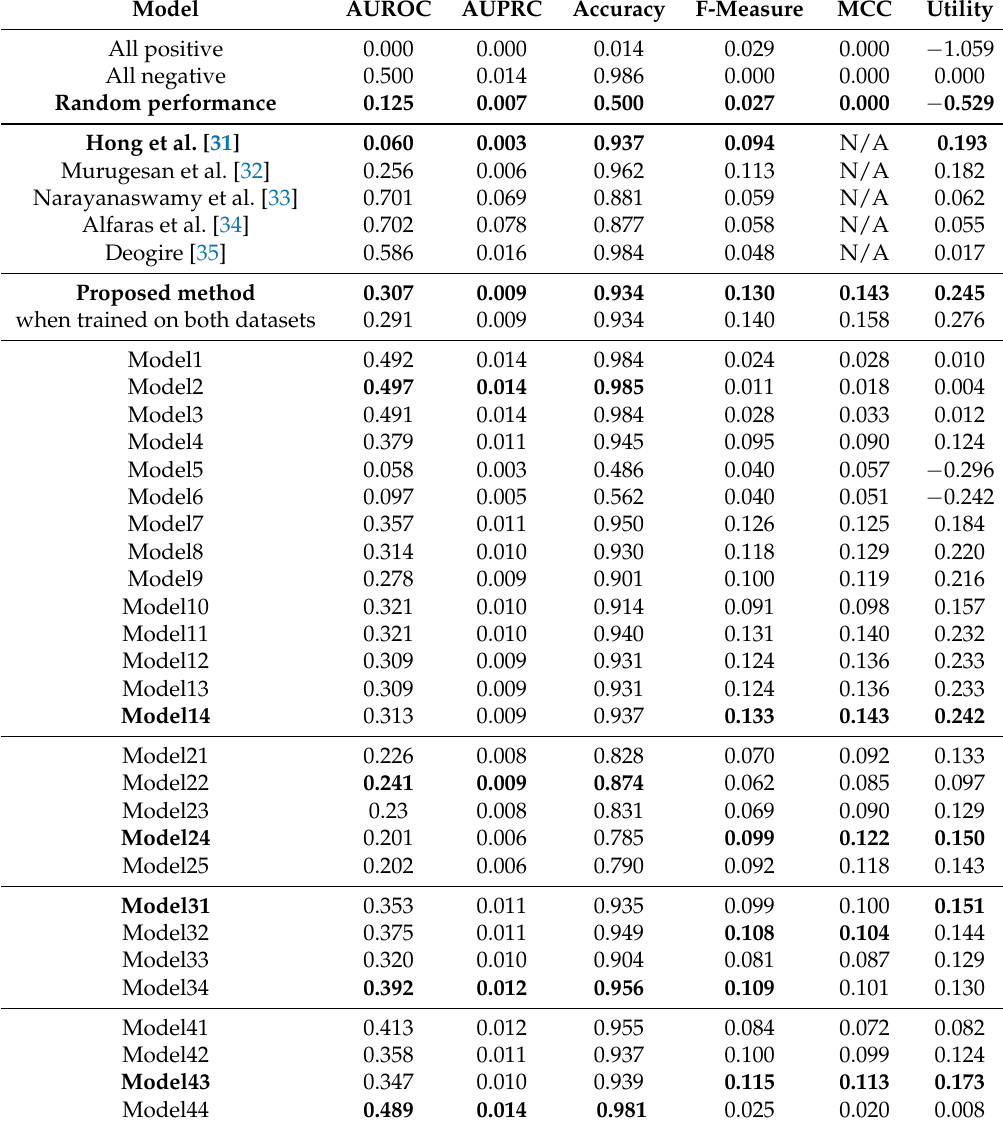
Table 2. Results of the investigated models, baseline scores, and five highest Utility scores on hidden test set from the challenge. Our Investigated models labeled from 1 to 14 were based on decision trees. Models labeled from 21 to 25 were based on naive Bayes algorithm. SVM based models were labeled from 31 to 34. Models labeled from 41 to 44 were using ensemble methods with hyperparameter search. Best performing models, having the highest Utility score, were